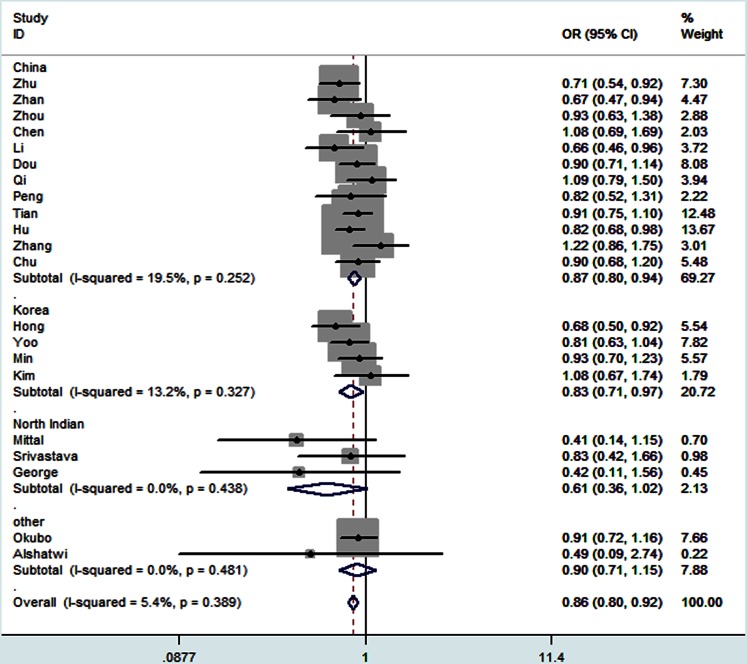
Forest plots of effect estimates for rs11614913 stratified by country (TT vs CC+CT).For each studies, the estimate of OR and its 95% CI is plotted with a box and a horizontal line. Filled diamond pooled OR and its 95% CI.